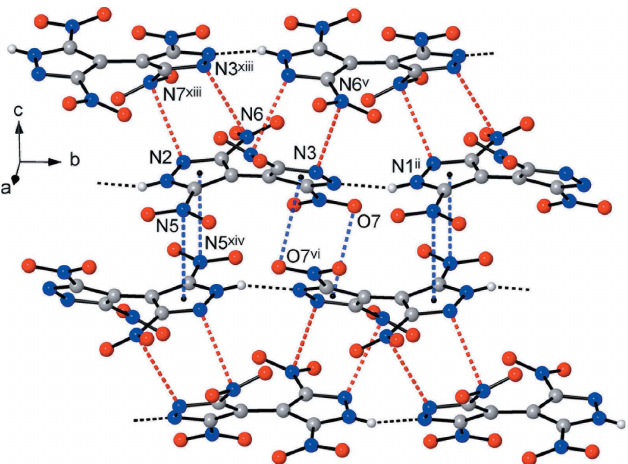
Figure 6 A suite of non-covalent interactions of the {H(TNBP)} (cid:3) anions, with two kinds of lone pair– (cid:3) -hole bonds (marked in red) and two kinds of nitro/ pyrazole stacks (marked in blue) complementing the conventional hydrogen bonding. [Symmetry codes: (ii) (cid:3) x + 1 , y + 1 , (cid:3) z + 1 ; (v) 2 2 2 (cid:3) x + 1, y + 1, (cid:3) z + 1 ; (vi) (cid:3) x + 1, y , (cid:3) z + 1 ; (xiii) (cid:3) x + 1 , (cid:3) y (cid:3) 1 , (cid:3) z ; (xiv) 2 2 2 2 x , y (cid:3) 1, z